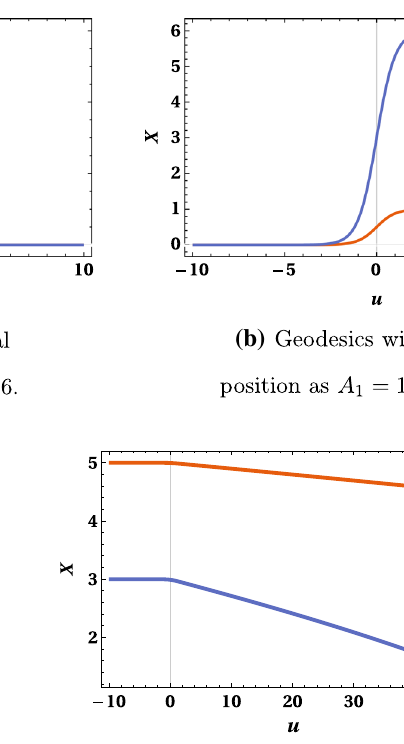
Fig. 2 ω = 1: Initial position of X for the two geodesics are 5 (orange) and 3 (blue)